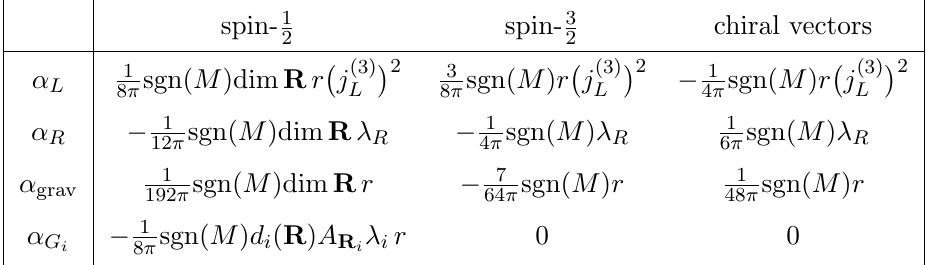
Table 3 . One-loop contributions of a single (cid:12)eld in the representation ( j (3) su (2) R g to the Chern-Simons terms. We have used the shorthand (cid:21) R = j R ( j R + 1)(2 j R + 1) and (cid:8) the dimension of the SU(2) R representation r = 2 j R +